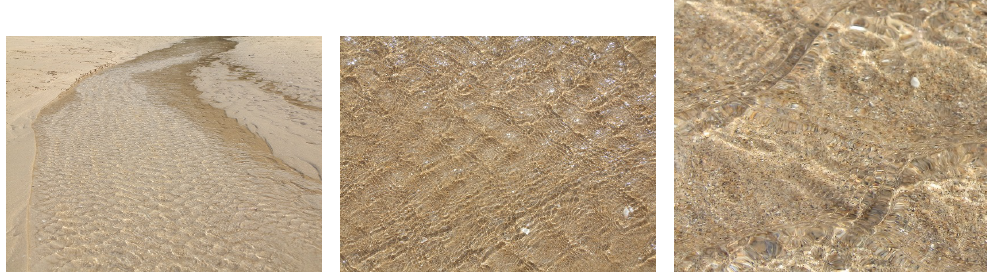
Figure 3. Complex pattern of surface waves due to a wave–flow interaction on the beach of Villers sur Mer. From left to right: increasing magnification. The current, due to the flowing stream and the wind, forces a herringbone/chevron pattern of waves. At small scales, one notes the presence of a capillary wave